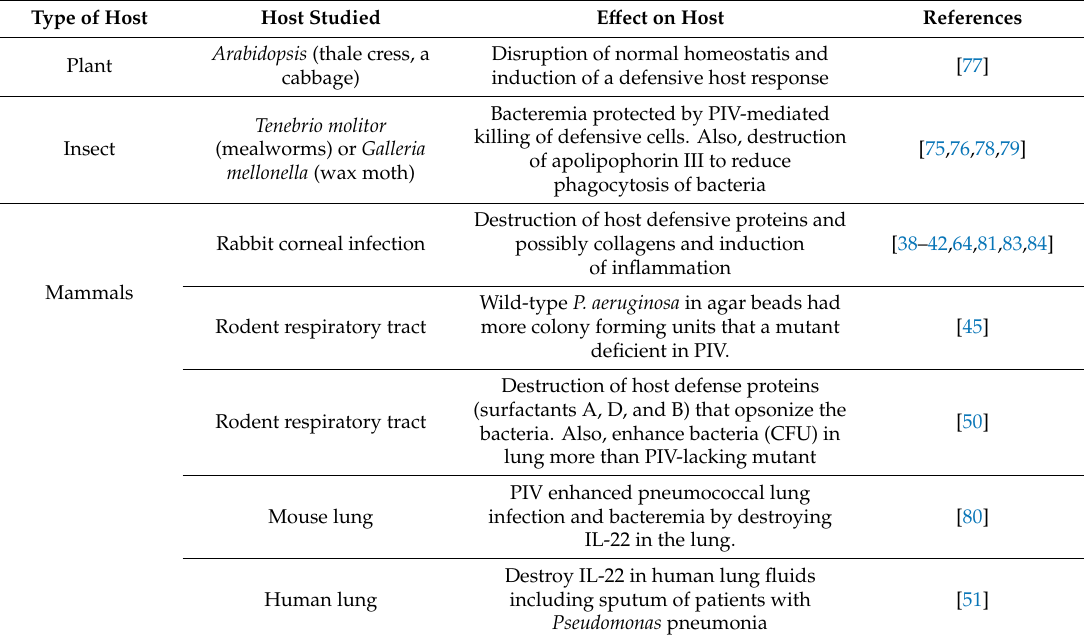
Table 2. Summary of the virulence functions of protease